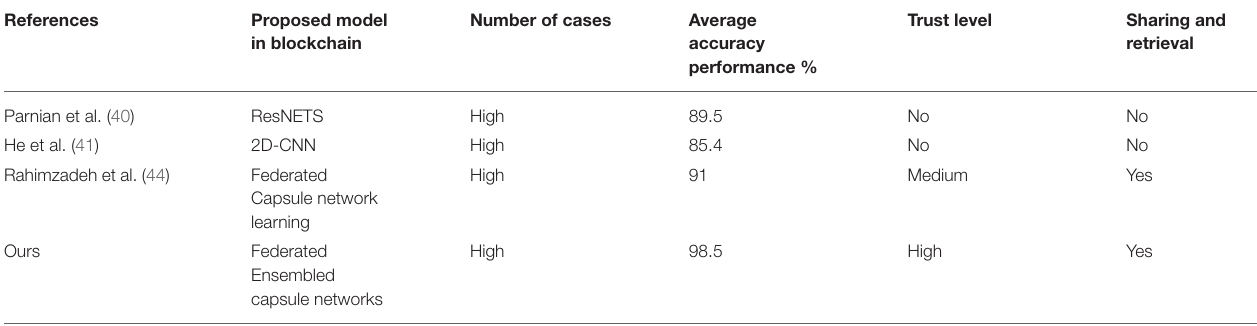
TABLE 5 | Comparative analysis between the blockchain-based learning models for COVID-19 detection of diseases using dataset 1.